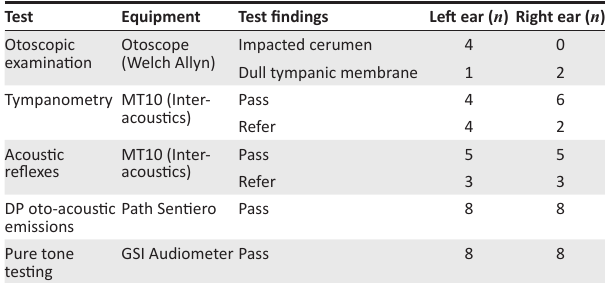
TABLE 3: Hearing screening results ( N = 8).